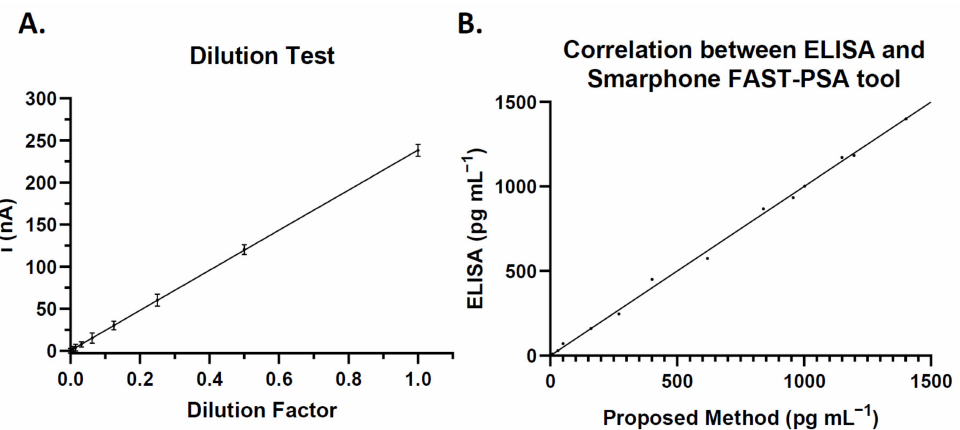
Figure 3. ( A ) Correlation between flow rates of electrochemical substrate dilution and the current generated on the electrode surface at − 100 mV. Each dot represents the mean of 5 determinations and the error bar corresponds to the standard deviation. ( B ) Correlation between the pH of electrochemical substrate dilution and the current generated on the electrode surface at − 100 mV. Each dot represents the mean of 5 determinations and the error bar corresponds to the standard deviation.